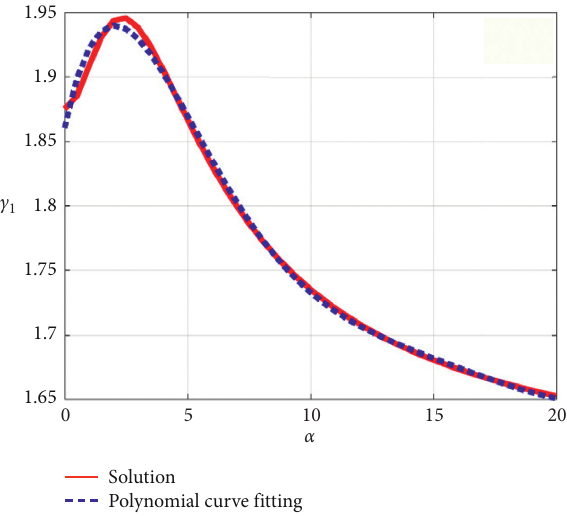
Figure 3: First root of the characteristic equation of the fixed-base CSF continuous